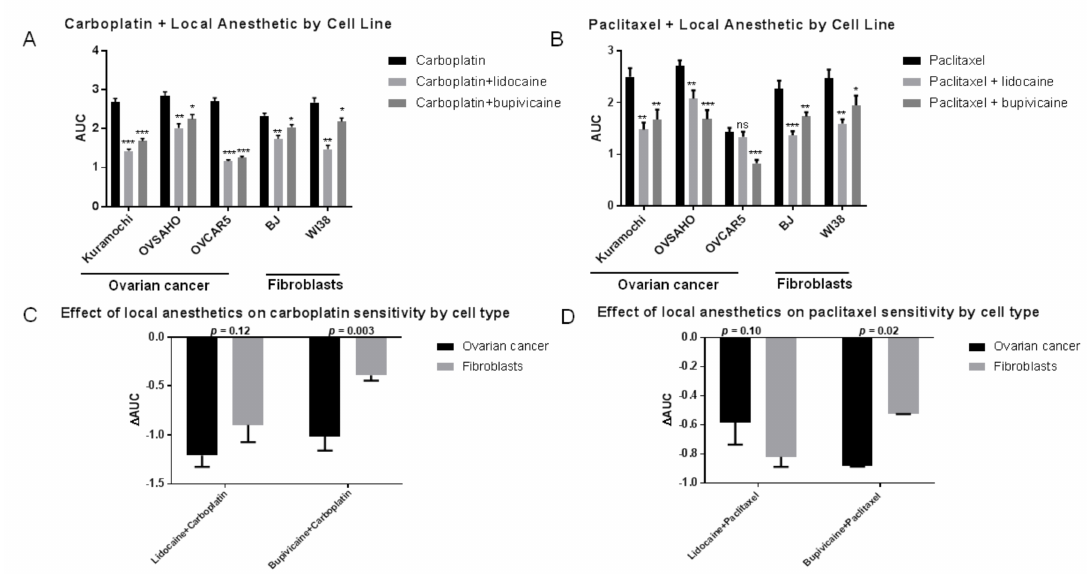
Figure 6. Change in AUC after addition of local anesthetic for ( A ) carboplatin and ( B ) paclitaxel by cell line. Comparisons for each cell line are relative to chemotherapy alone. Relative change in AUC between fibroblasts and ovarian cancer cells after addition of local anesthetic for ( C ) carboplatin and ( D ) paclitaxel. * p < 0.05, ** p < 0.01, *** p < 0.001, ns—not